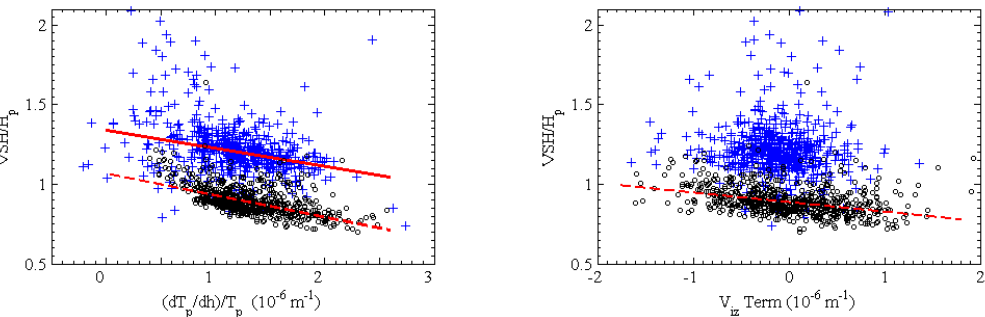
Fig. 4. (Left) Scatterplots of the relative gradient of plasma temperature (d T p /dh)/ T p versus VSH/Hp, the ratio of the vertical scale height VSH to plasma scale height H p . (Right) Scatterplots of the velocity term in Eq. (2) versus VSH/ H p . The curves show the fitting linear trends. In each panel, symbol “+” denotes nighttime values while symbol “o” for daytime